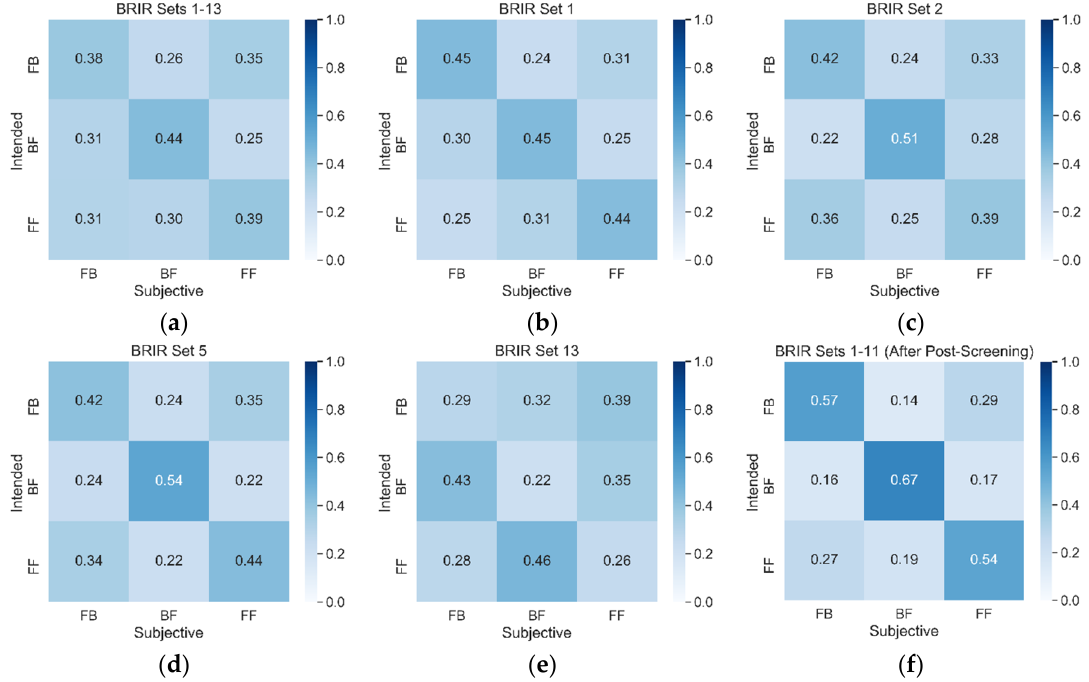
Figure 2. Examples of confusion matrices obtained from human listeners: ( a ) All data; ( b ) BRIR set 1; ( c ) BRIR set 2; ( d ) BRIR set 5; ( e ) BRIR set 13; ( f ) BRIR sets 1-11 (data after post-screening). Vertical axis represents the classification results obtained from the listeners whereas the vertical axis denotes